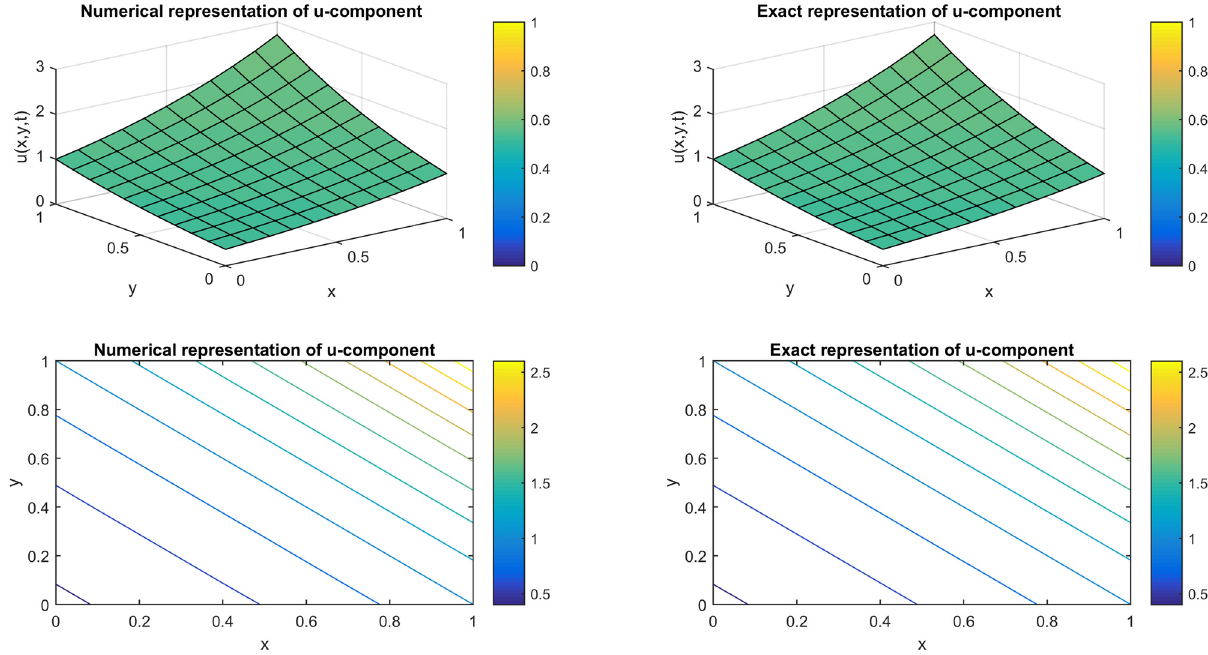
Figure 16: Surface and contour plots for u component at = t 1 for = N 11 , = α 1 , = β 1 , = t Δ 0.0001 , and = τ 0.5 using Method II regarding Example